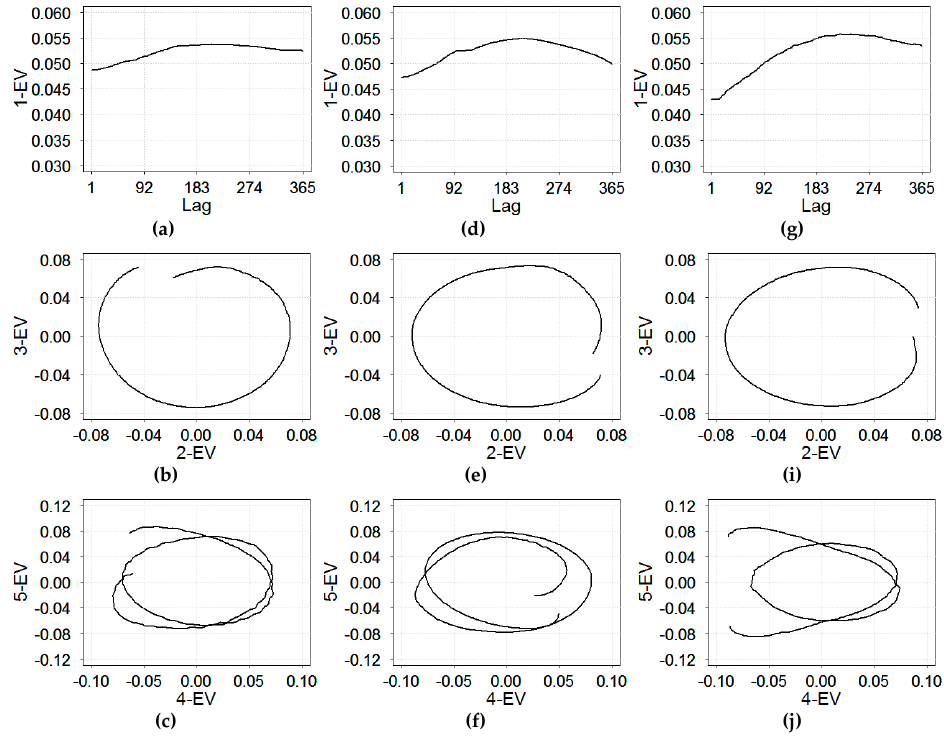
Figure 4. Plots of the eigenvectors (EV) pairs: 1-EV and lag, 2–EV and 3-EV, and 4-EV and 5-EV for Chelyabinsk ( а – c ); Yekaterinburg ( d – f ); and Barnaul ( g – j ).